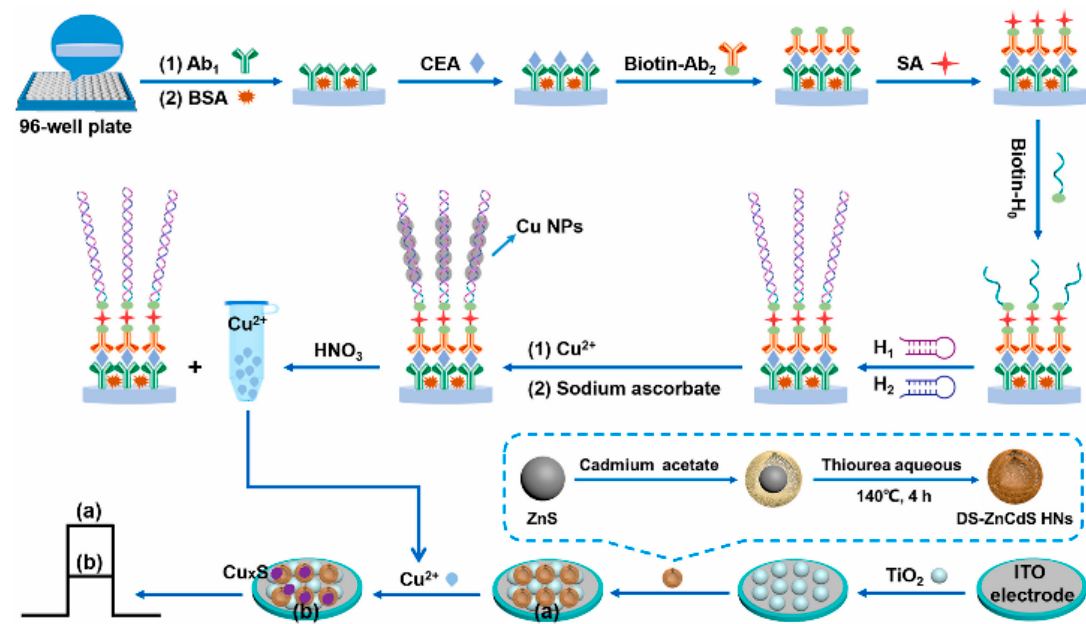
Figure 8. Construction of the designed photoelectrochemical immunosensor for CEA monitoring based on the quenching of HCR-modulated Cu 2+ sources toward TiO 2 -sensitized DS-ZnCdS HNs. Reprinted with permission from ref. [105]. Copyright 2021 Elsevier.